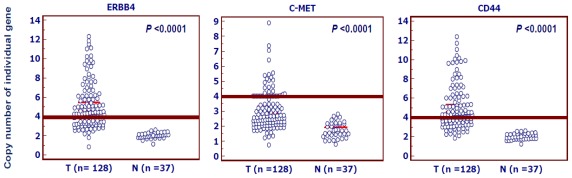
The copy number of ERBB4, C-MET and CD44 genes corresponding to each individual case of gastric cancers and normal gastric tissues (circle). Real-time quantitative PCR was performed to evaluate their copy numbers in a cohort of gastric cancers and normal gastric tissues. Details are as described in Methods. Horizontal lines indicate a 95% confidence interval for the sample mean. T: tumor tissues; N: normal gastric tissues.